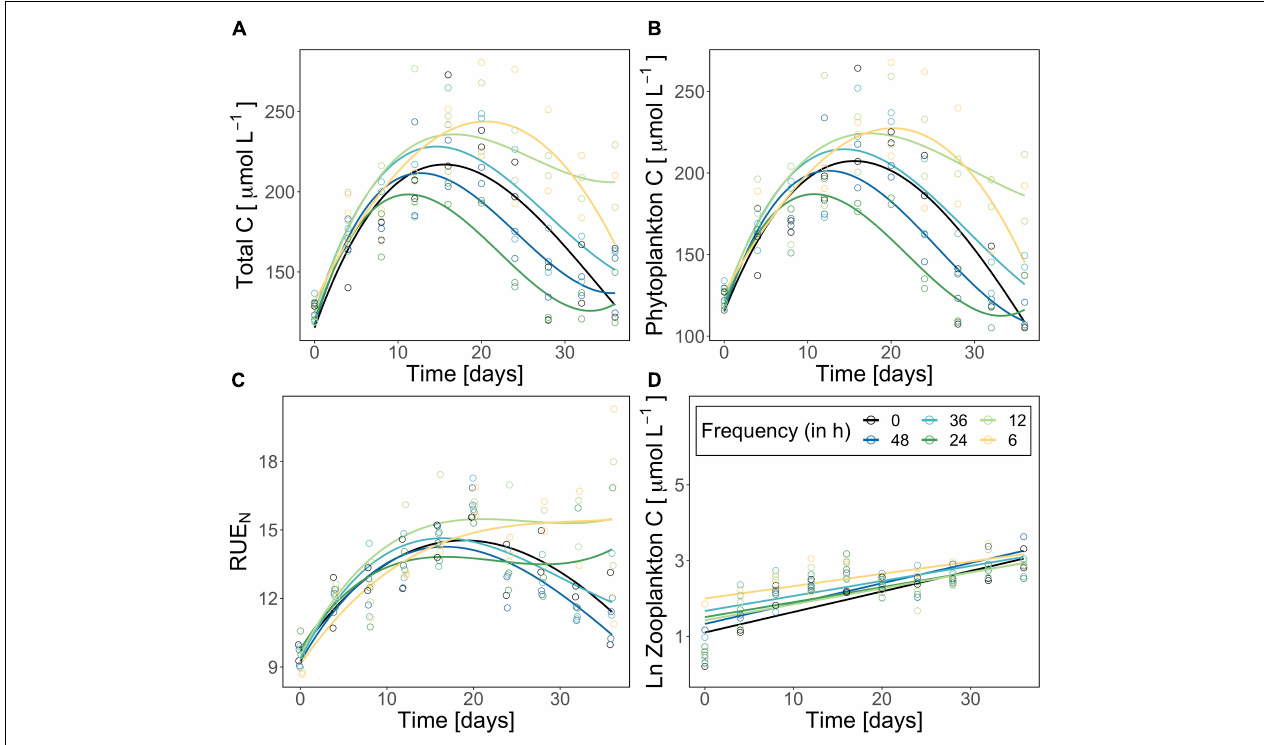
FIGURE 2 | Total plankton biomass (carbon in µ mol/L) (A) , corrected phytoplankton biomass (carbon in µ mol/L) (B) , resource use efficiency of nitrogen (C) , and ln-transformed zooplankton biomass (carbon in µ mol/L) (D) during the experiment. The constant treatment is in black, fluctuation treatments are highlighted following a color gradient (dark blue fluctuation every 48 h—yellow fluctuation every 6 h). Each point represents one replicate ( n = 2). Please note the different y-scales for panels (A–C) . Curves/lines are loess-fits added to visualize the trend over time. TABLE 1 | Results of the statistical analysis for total Particulate Organic Carbon (POC), phytoplankton POC (total POC corrected for zooplankton carbon as a proxy for phytoplankton biomass), and resource use efficiency of nitrogen (RUE of N) using GAMMs, and zooplankton particulate organic carbon (POC, biomass proxy) using a linear mixed model. Total POC Phytoplankton (corrected) POC RUE of N Zooplankton POC